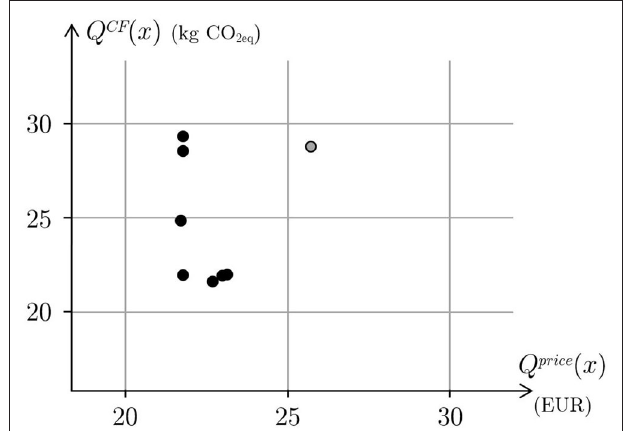
FIGURE 2 | The price and the carbon footprint of several optimal menus obtained for different desired targets of price and carbon footprint (black circles). The gray circle represents the price and the carbon footprint of the average menu.